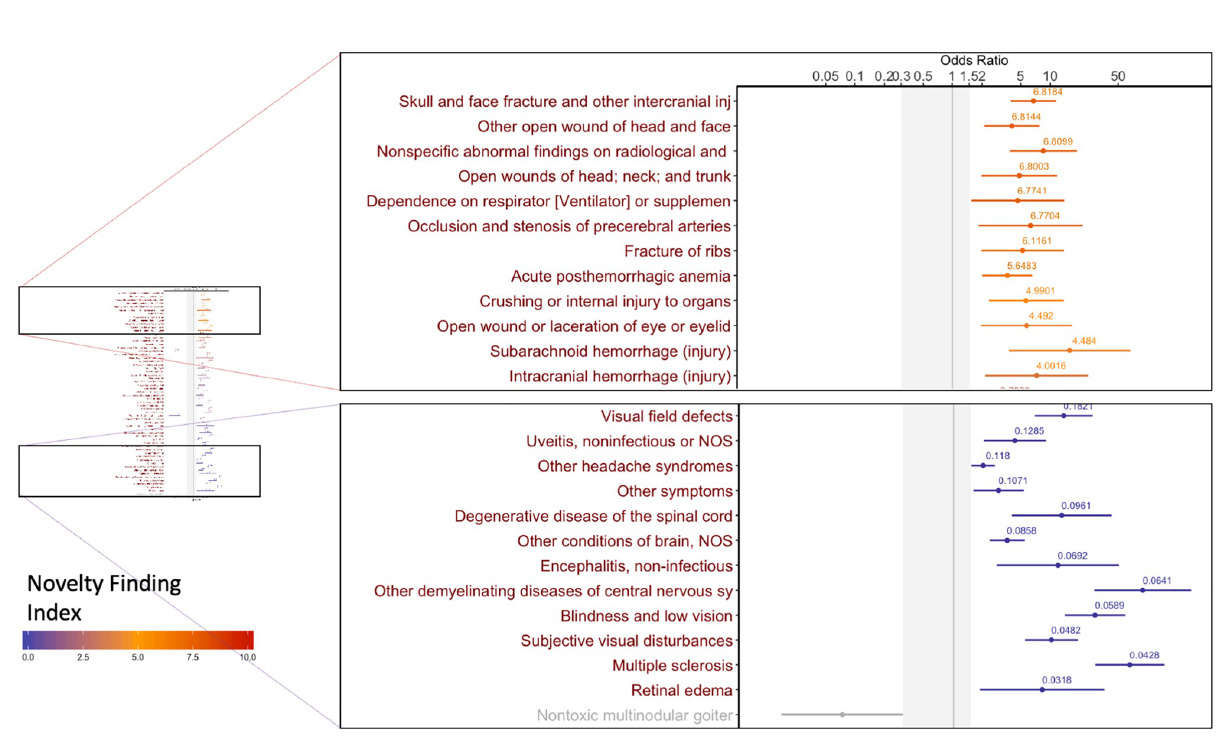
Fig 5. Significant associations 0–5 years after a diagnosis of optic neuritis presented as an odds ratio plot. Each dot represents the point estimate of the odds ratio computed from a logistic regression and the line indicates its 95% confidence interval. Each condition is color coded by its novelty finding index, the value of which is displayed above the confidence